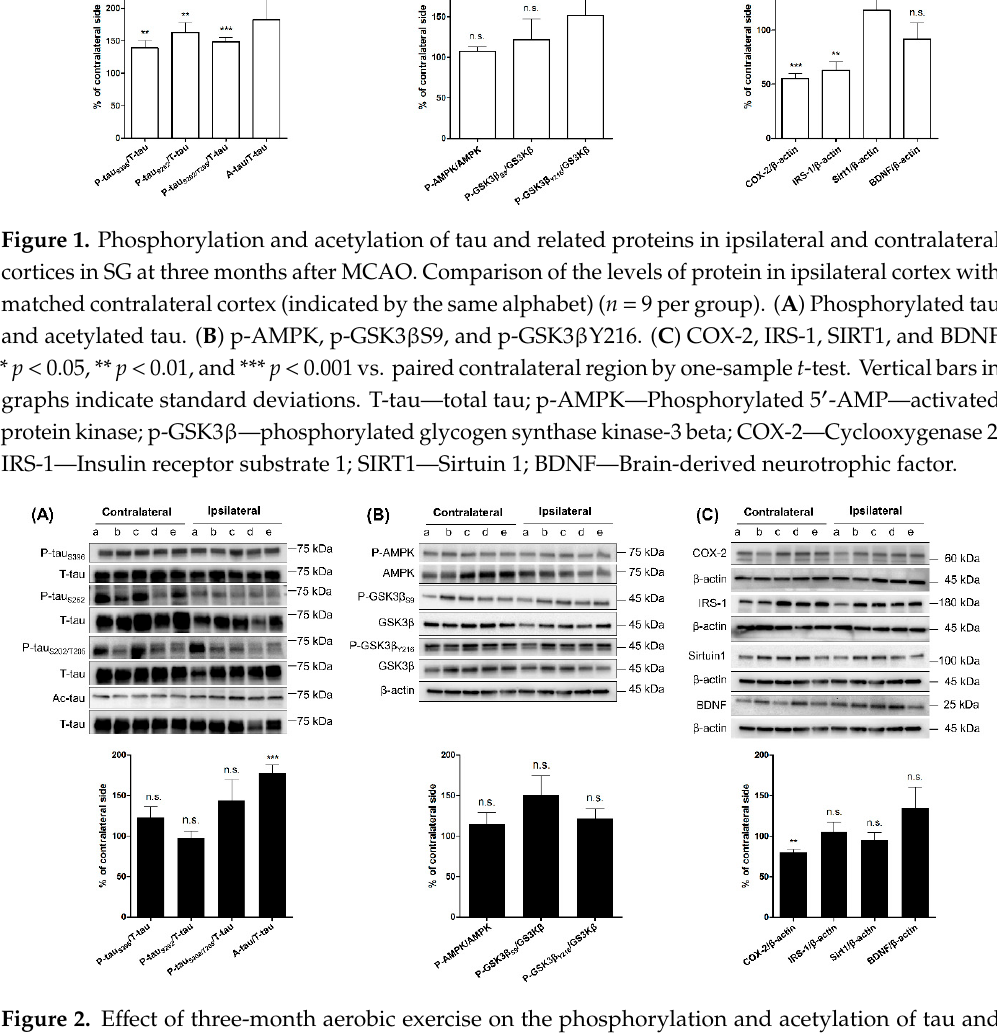
Figure 2. Effect of three-month aerobic exercise on the phosphorylation and acetylation of tau and related proteins in ipsilateral and contralateral cortices in RG. Comparison of the levels of protein in ipsilateral cortex with matched contralateral cortex (indicated by the same alphabet) ( n = 9 per group). ( A ) Phosphorylated tau and acetylated tau. ( B ) p-AMPK, p-GSK3 β S9, and p-GSK3 β Y216. ( C ) COX-2, IRS-1, SIRT1, and BDNF. * p < 0.05, ** p < 0.01, and *** p < 0.001 vs. paired contralateral region by one-sample t-test. Vertical bars in graphs indicate standard deviations. T-tau—total tau; p-AMPK—Phosphorylated 5 ′ -AMP-activated protein kinase; p-GSK3 β —phosphorylated glycogen synthase kinase-3 beta; COX-2—Cyclooxygenase 2; IRS-1—Insulin receptor substrate 1; SIRT1—Sirtuin 1; BDNF—Brain-derived neurotrophic factor.